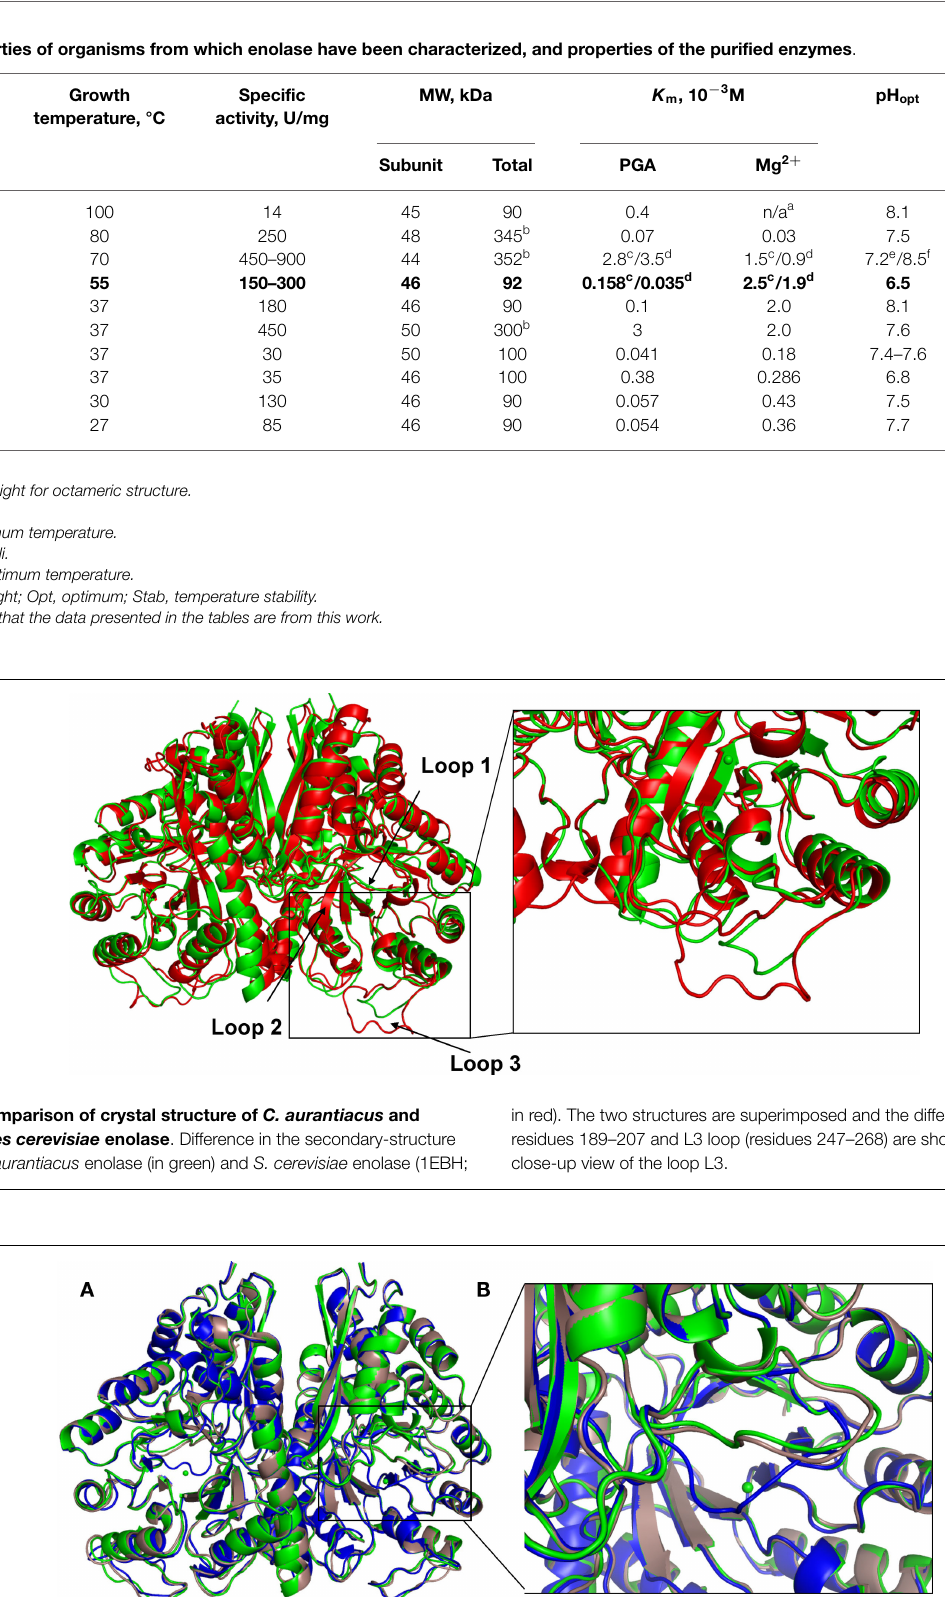
Frontiers in Bioengineering and Biotechnology |